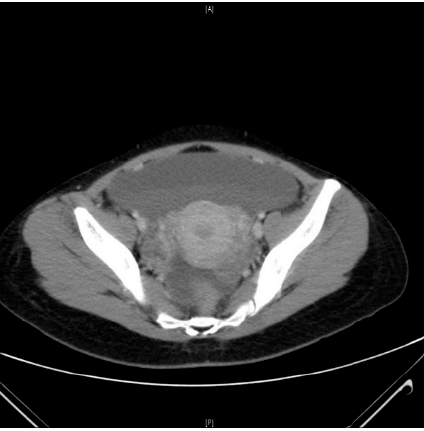
Figure 2. Computed tomography (CT) scan of pelvis demonstrating ascites with persistent left adnexal lesion.